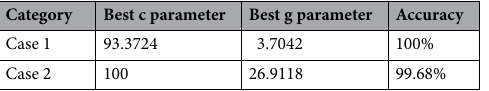
Table 3. Best parameters and accuracy in Case 1 and Case